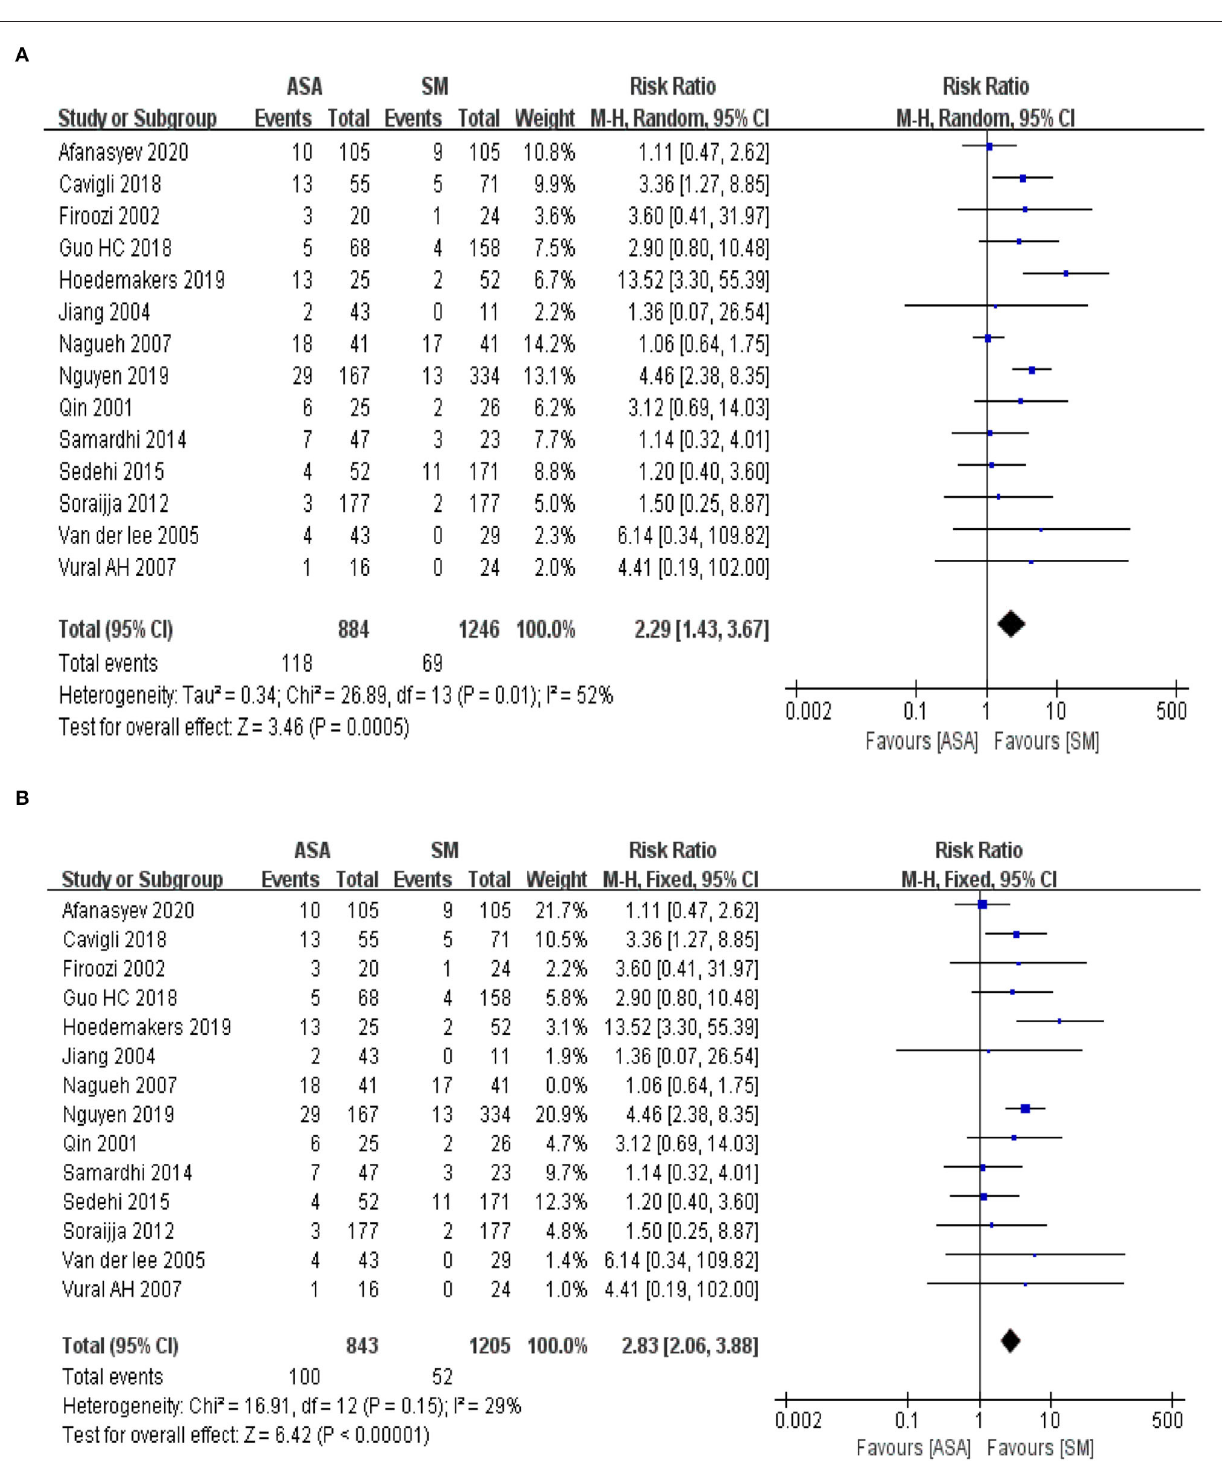
FIGURE 5 | (A) The forest map for the Meta analyses of risk for permanent pacemaker implantation. M-H, Mantel-Haenszelt test; CI, confidence interval; Random, random effect model. (B) The adjust forest map for the Meta analyses of risk for permanent pacemaker implantation. M-H, Mantel-Haenszelt test; CI, confidence interval; Fixed, fixed effect